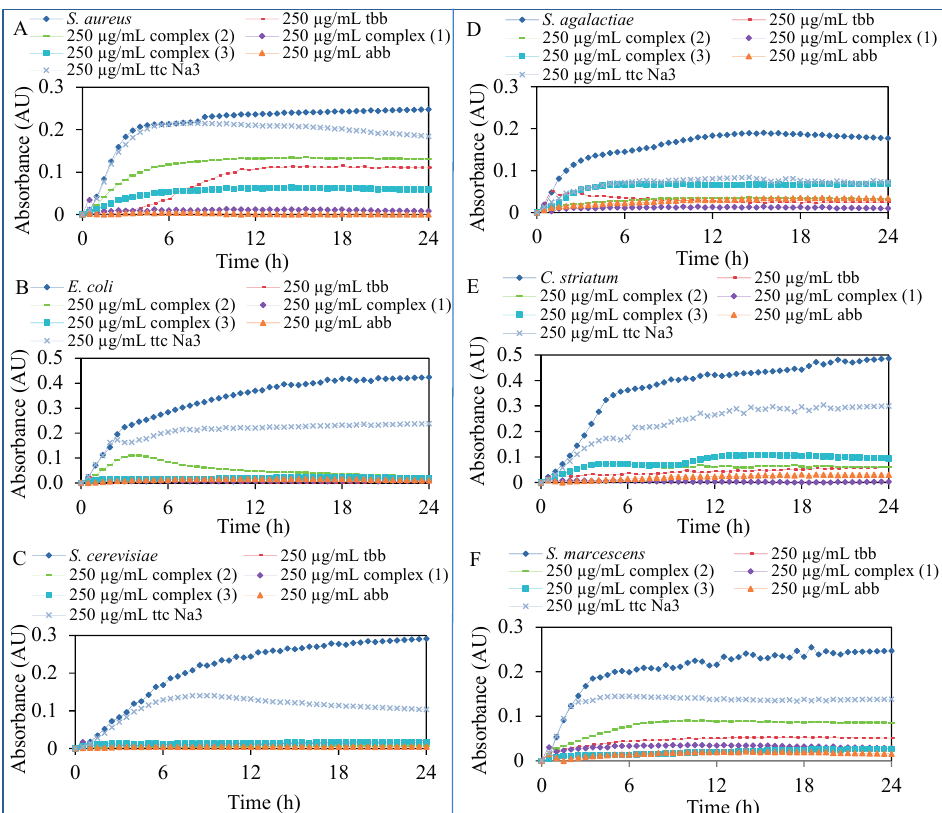
Figure 6. Testing of antimicrobial activity of 250 μ g/mL concentration of ligands and complexes after 24 h of treatment on: ( A ) S. aureus ; ( B ) E. coli ; ( C ) S. cerevisiae ; ( D ) S. agalactiae ; ( E ) C. striatum ; ( F ) S. marcescens